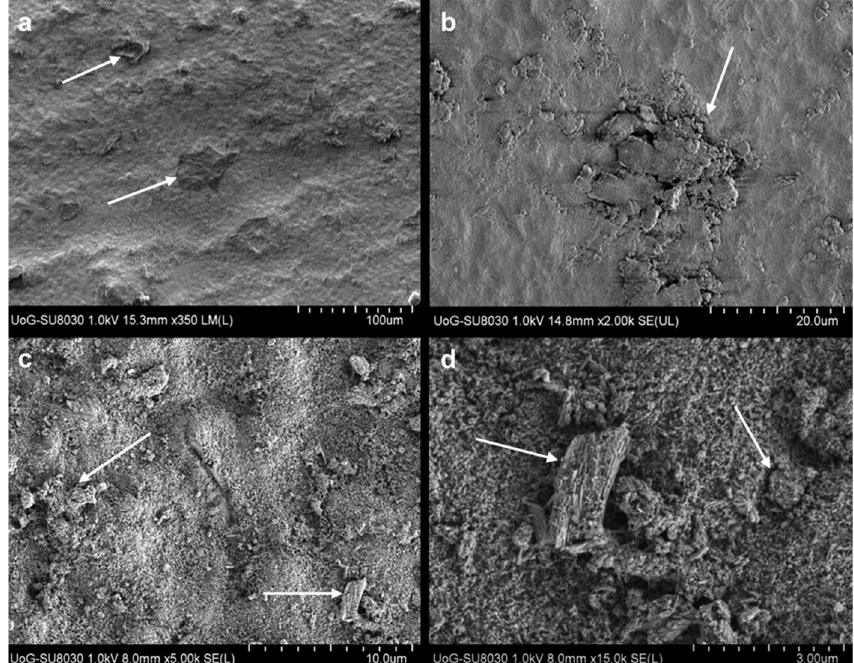
Figure 3. Scanning electron microscopy image shows surface HA deposits are seen on artificially demineralised enamel surfaces after treatment with Mirasensitive HA toothpaste. Subfigures a b c d shows porous enamel at increasing magnifications; ( a ) at ×350 magnification, ( b ) at ×2000 magnification, ( c ) at ×5000 magnification, and ( d ) at ×15,000 magnification. Irregularities in the enamel are filled with HA deposits (some deposits are pointed to by white arrows). Reproduced with permission from (Elizabeta S. Gjorgievska, Cambridge University Press, 2013) [46] . Natural enamel and dentine consist of HA with trace amounts of other ions such as Na + , Mg 2+ , Fe 2+ , F − , Zn 2+ [36]. To mimic the natural composition of human teeth and bone